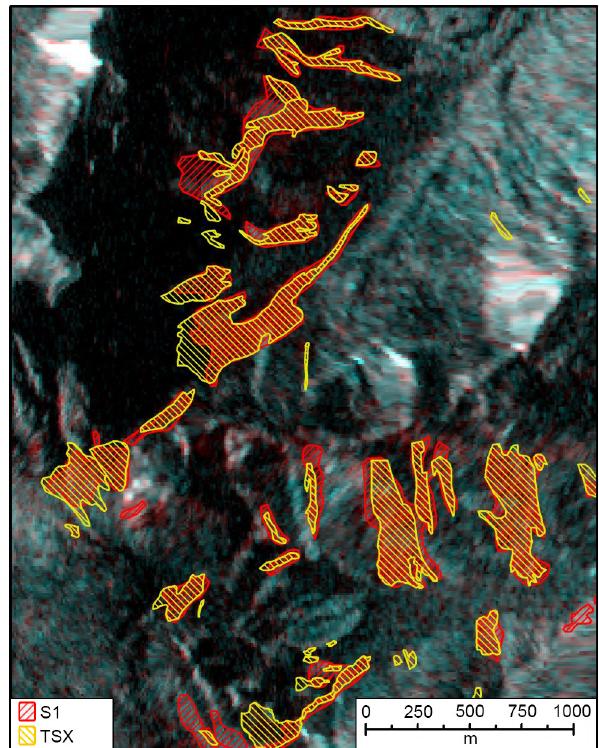
Figure 6. S1/TSX: manually mapped new avalanches (in red) from the change detection image S1(12-31 / 01-12) compared to manually mapped new avalanches from tsx(12-31 / 01-11), in yellow. No mask is shown for avalanches classified as old or unsure. The masks were derived from the radar images shown in Fig. 4a and b. Image or- thorectified with swissALTI3D © 2019 swisstopo (JD100042), re- produced with the authorization of swisstopo (JA100120). Table 4. (a) Number of manually detected new avalanches in S1(12- 31 / 01-12) which were also detected as new or unsure in the change detection image tsx(12-31 / 01-11). (b) Reverse correspondence.